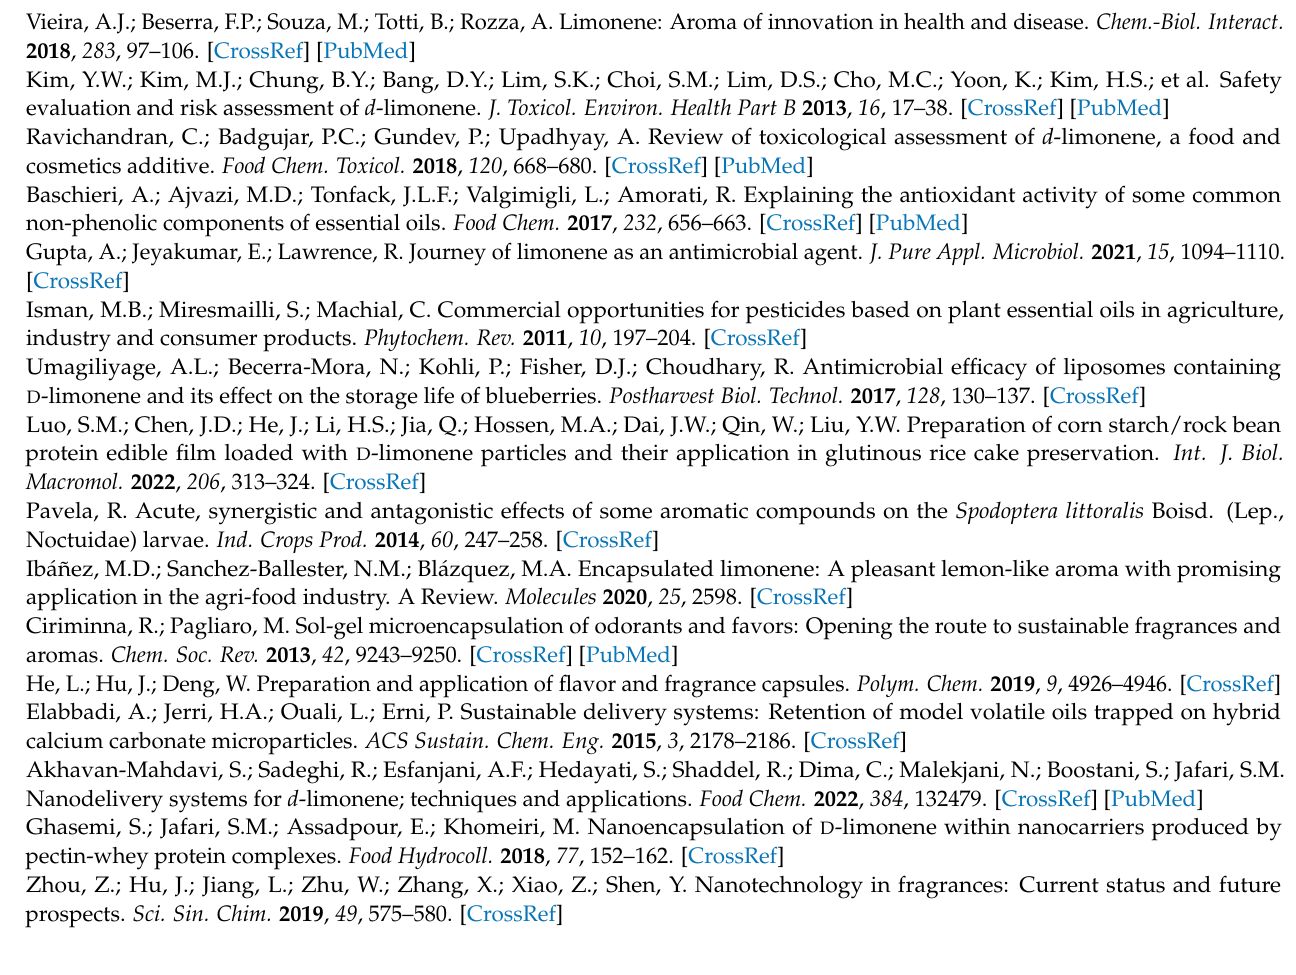
Figure S5: DLS curves of PMO NPs, Figure S6: DTG curves of MSN, E-PMO, and P-PMO NPs, Figure S7: TGA curves of NPs before and after adsorption of myrcene/cymene, Figure S8: IR spectra of NPs before and after fragrance adsorption, Tables S1 and S2: Reaction conditions for PMO synthesis and characterization data. Reference [65] is cited in the supplementary